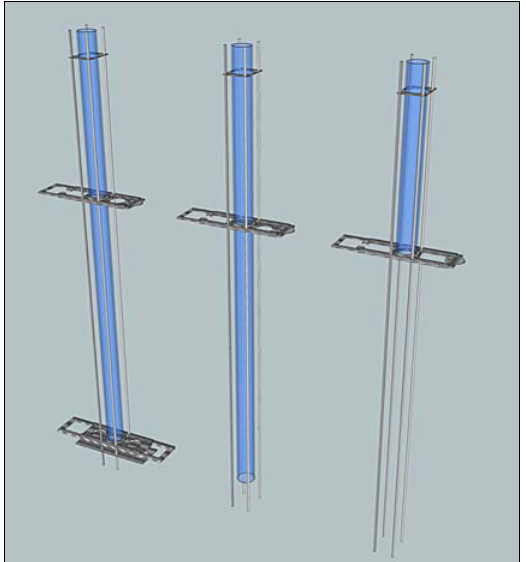
Figure 1. Sketches of the three setups used for powder flow experi- ments: closed outlet vertical pipe (left), open outlet (middle) and setup without the pipe (right), where the vertical pipe (1200 mm drop region) is